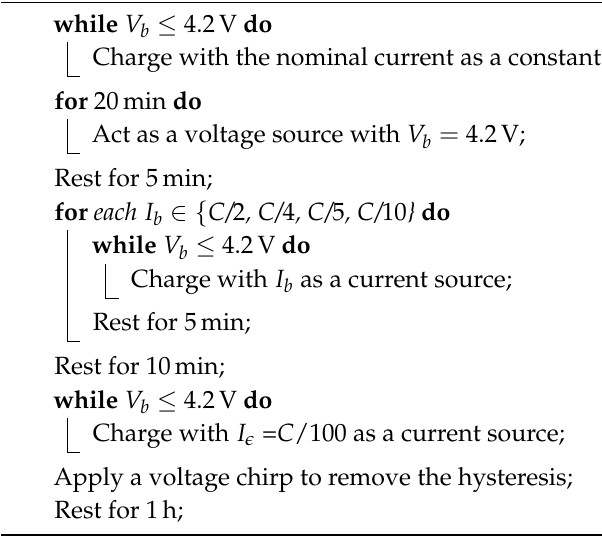
Algorithm A4: Process of charging the battery to the fully charged initial state.